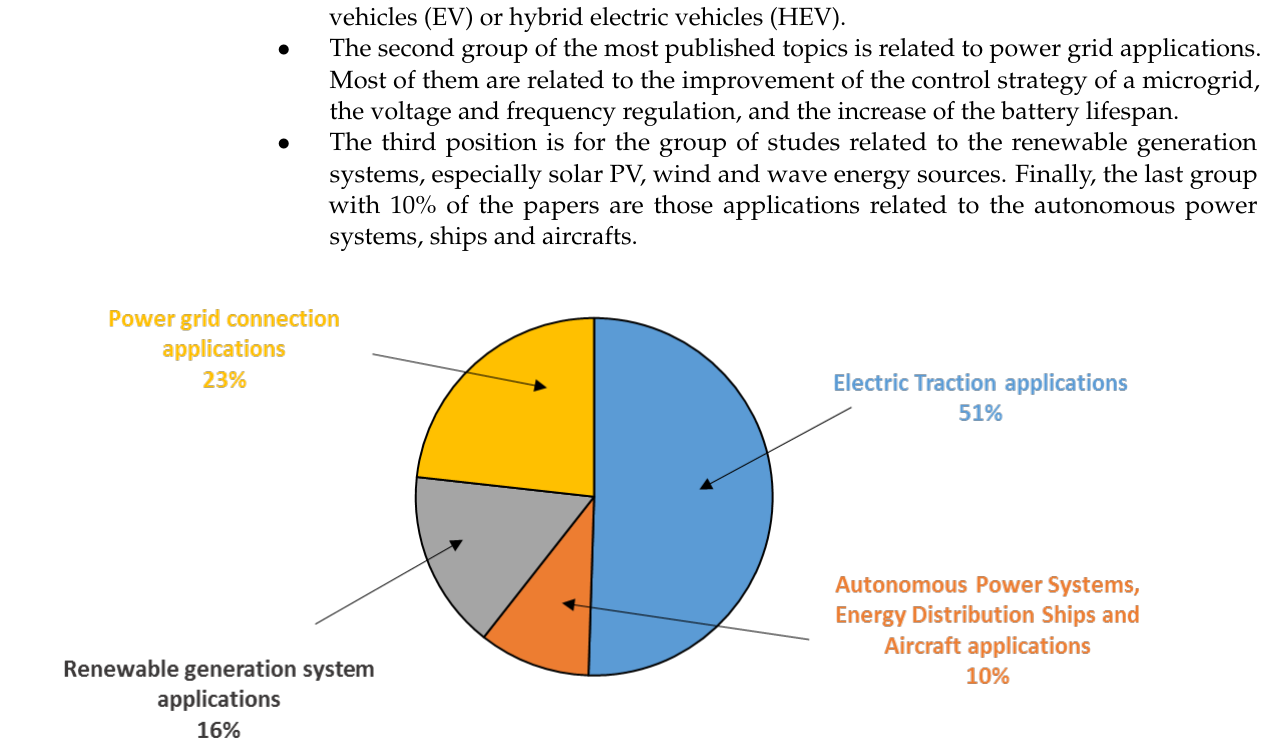
Figure 4. Classification of the research publications related to SCs in the last decade respect to their application.